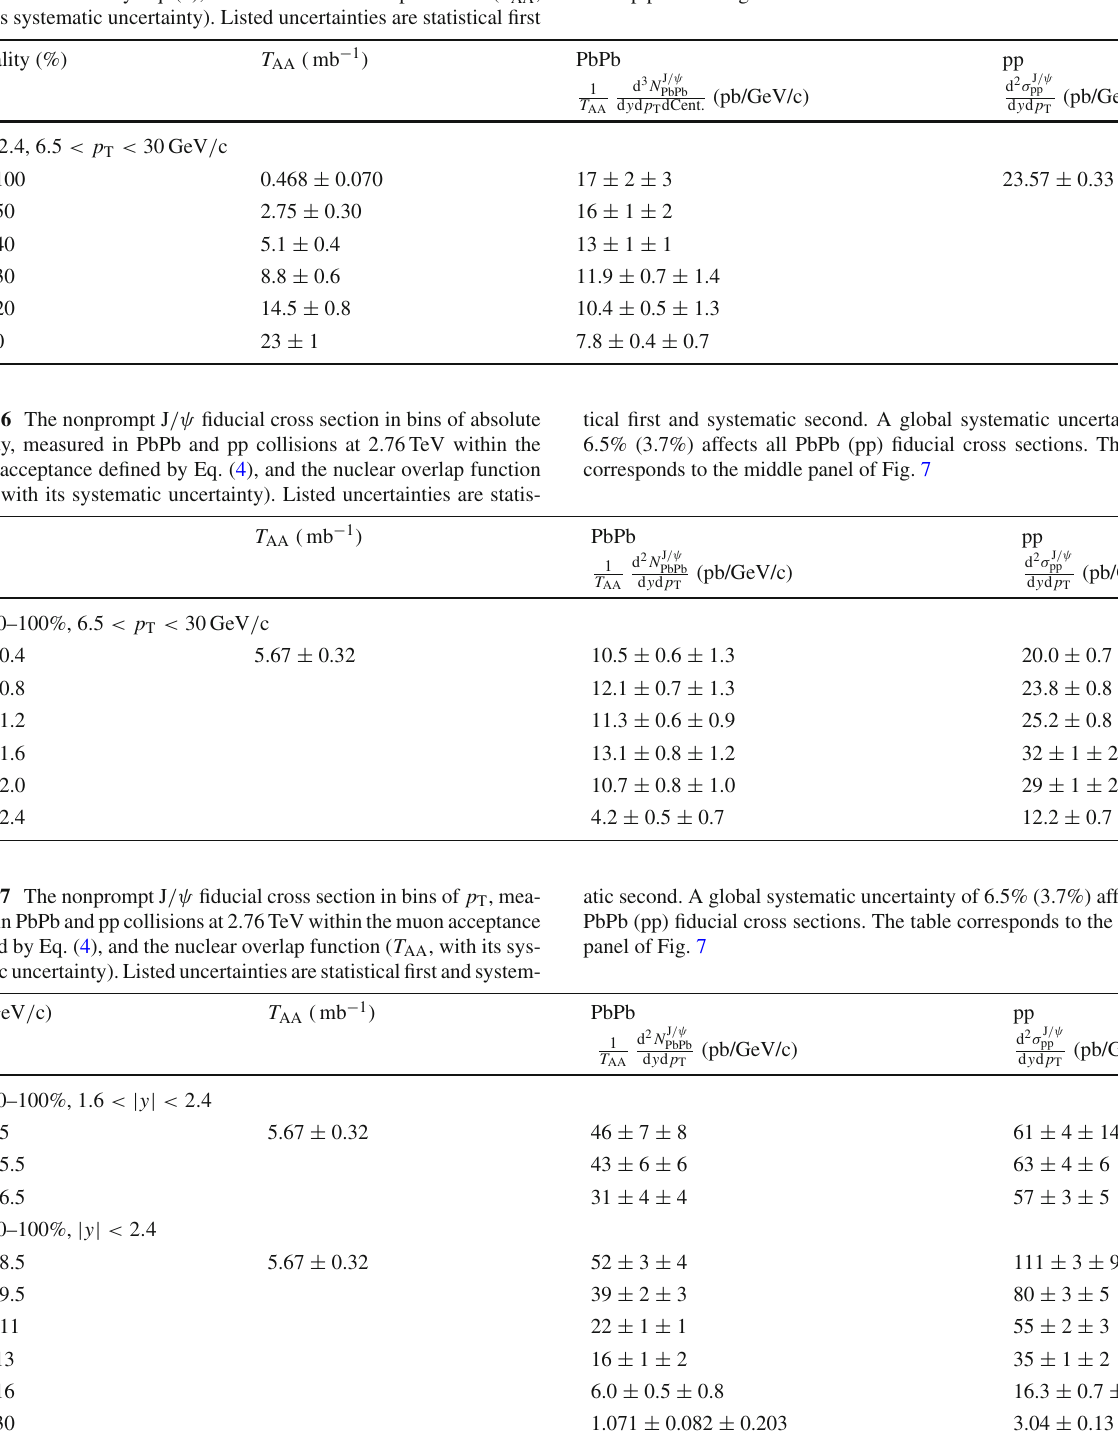
and systematic second. A global systematic uncertainty of 3.2% (3.7%) affects all PbPb (pp) fiducial cross sections. The table corresponds to the top panel of Fig. 7